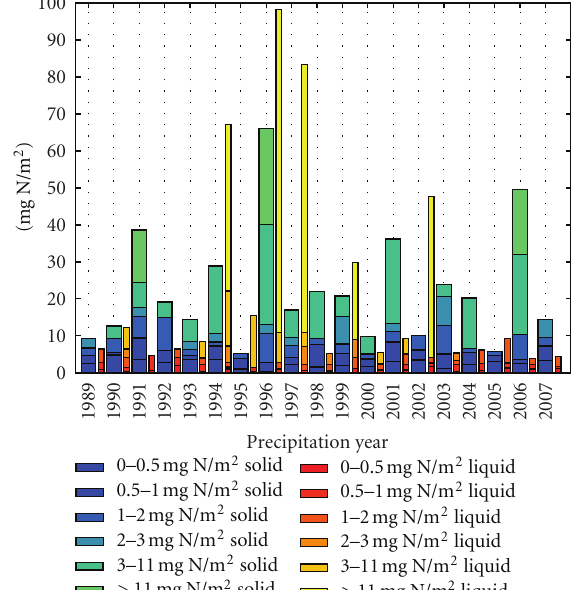
Figure 6: Annual budgets for nitrogen wet deposition through ammonium. Wide bars: solid precipitation season; narrow bars: liquid precipitation season.